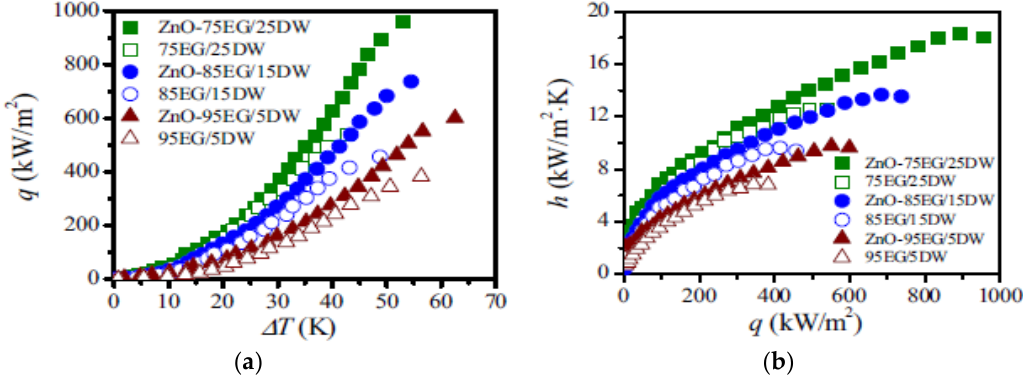
Figure 12. Boiling curves for ZnO-EG/DW nanofluids and EG/DW mixtures. ( a ) Boiling heat transfer curve. ( b ) Boiling heat transfer coefficient [101].